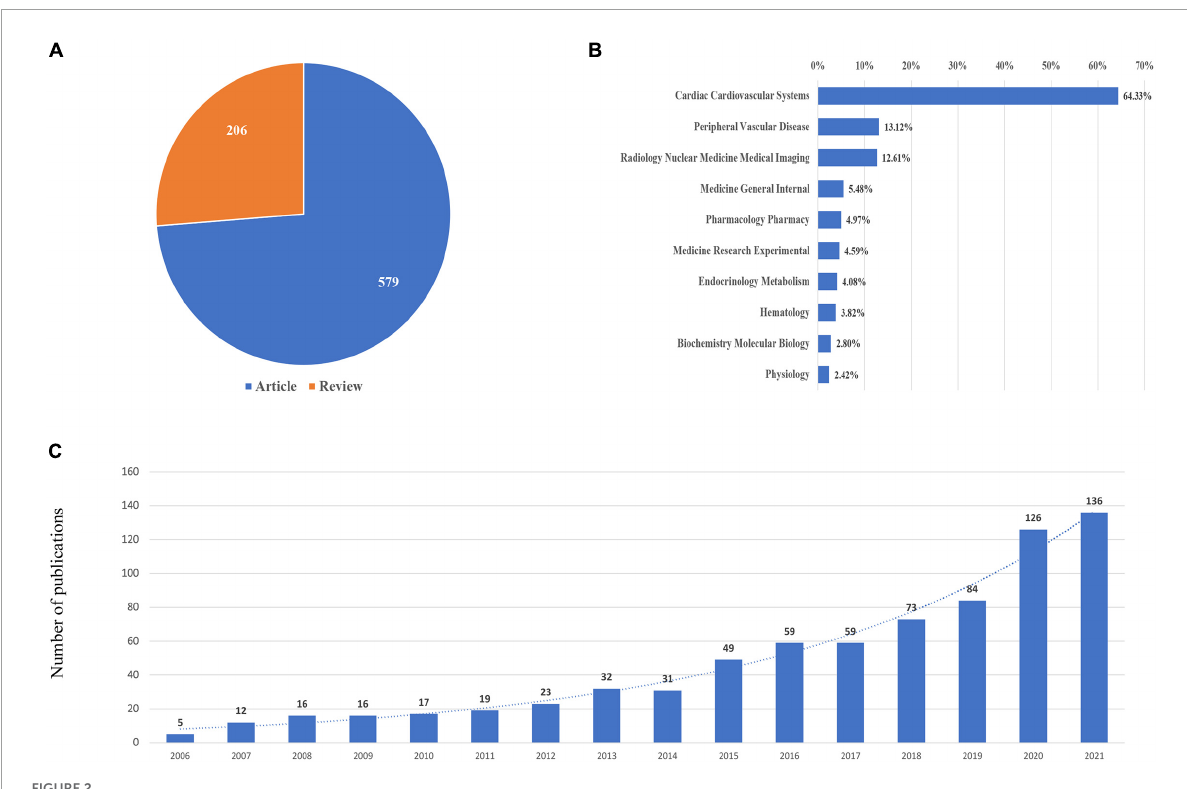
FIGURE2 Yearly quantity and literature type of publications on CMD from 2000 to 2021. (A) Literature types distribution. (B) Subject categories distribution. (C) Annual publications quantitative